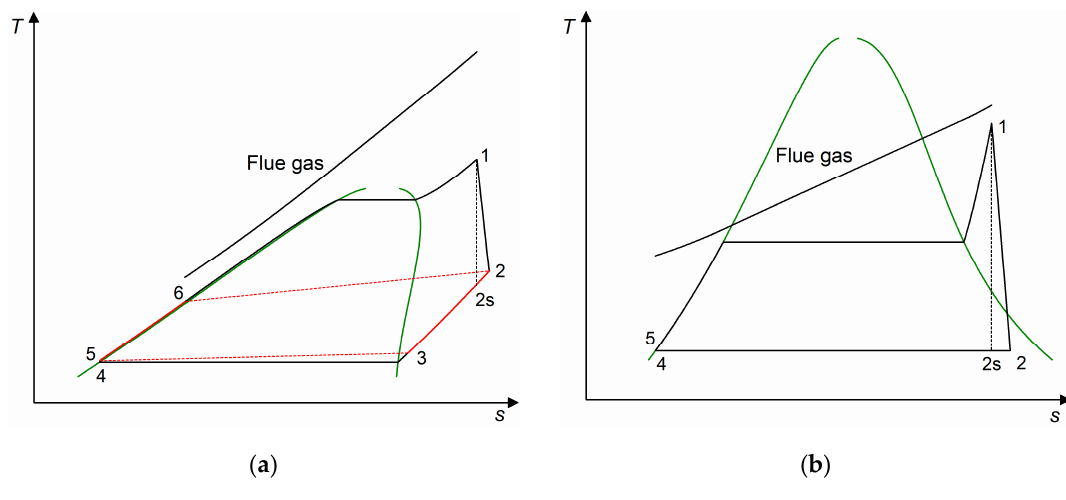
Figure 2. T–s diagram of the regenerative: ( a ) ORC; ( b ) SRC.